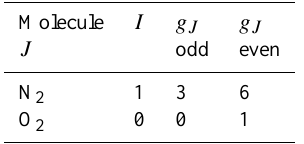
Table 2. The statistical weight factor g J due to nuclear spin (I) statistics for odd and even shell angular momentum J of the respec- tive N 2 or O 2 molecule.